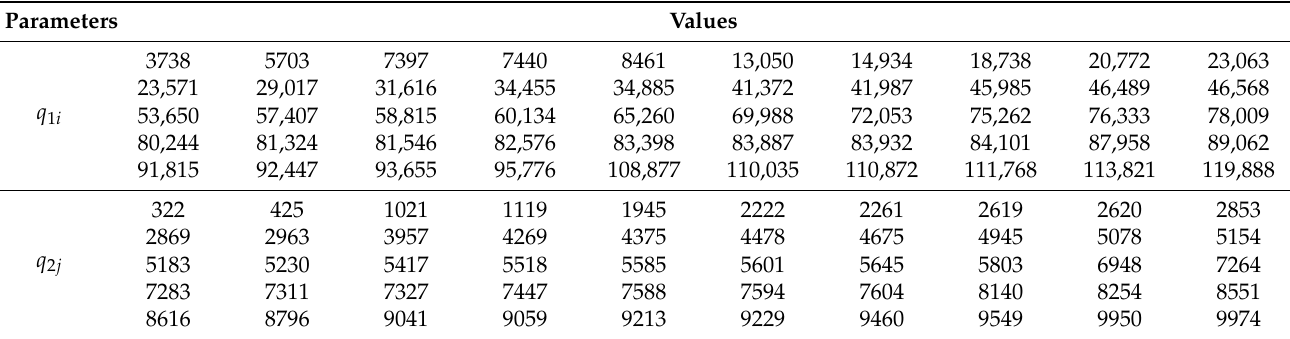
Table 4. Two-dimensional random data points ( q 1 i , q 2 j )